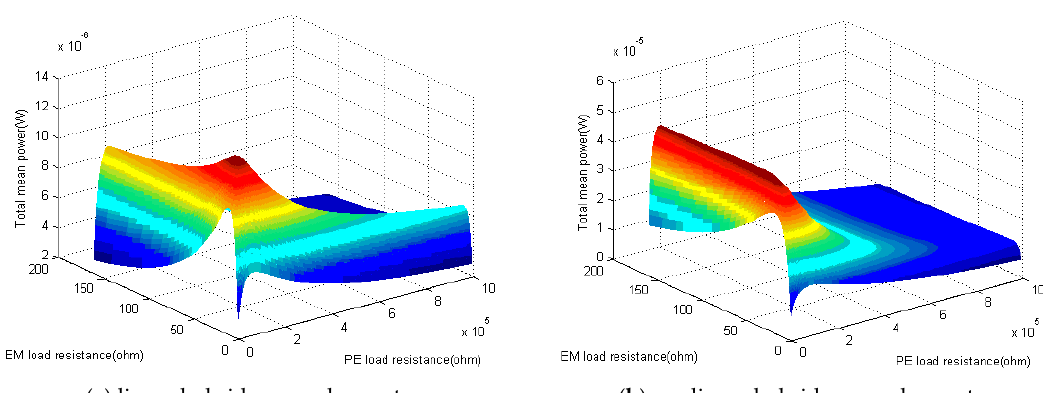
Figure 2. Total mean power of hybrid energy harvester with different load resistances. Table 4. Values of nonlinear and linear hybrid energy harvester.